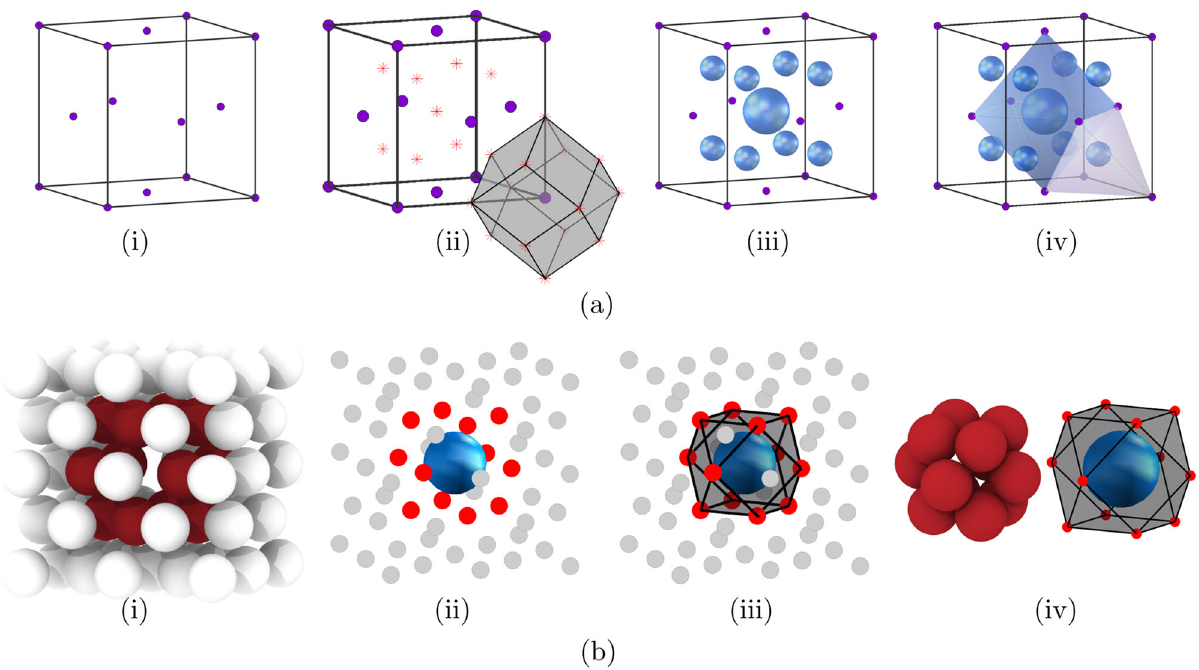
Fig. 1 The Voronoi vertex clustering algorithm for identifying the polyhedral unit structure of a an fcc single-crystal region and b a vacancy point defect is illustrated. In a (i), the unit cell of an fcc lattice is provided and in a (ii), the Voronoi polyhedron of one of the atoms is shown. Also highlighted are the Voronoi vertices, obtained by constructing the Voronoi polyhedra of all the atoms in the system. In a (iii), the VV- spheres that fall within the unit cell are shown. In a (iv), the octahedron and tetrahedron corresponding to the two distinct types of VV-spheres are depicted. In the case of the vacancy, in b (i), the fcc lattice with a vacancy is shown and the atoms surrounding the vacancy are highlighted. In b (ii), the VV-sphere that is located within the vacancy is illustrated and the atoms that have contributed to the creation of this sphere are highlighted in red. These atoms are the same as those surrounding the vacancy in b (i). The polyhedron that is obtained by triangulating the atoms in b (iii) is the cuboctahedron, which is identi fi ed as the polyhedral unit model of a vacancy in the fcc